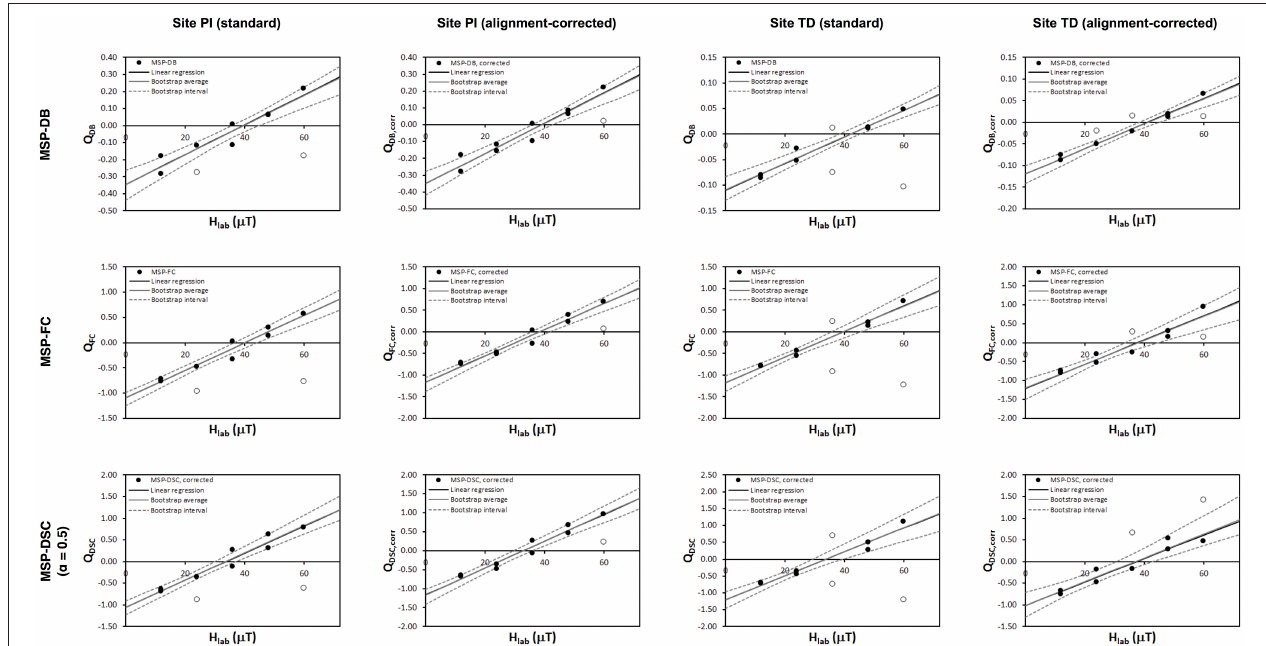
FIGURE 2 | MSP-DB, MSP-FC, and MSP-DSC plots (standard and alignment-corrected) for sites PI and TD which were given a full TRM at 40 µ T in the